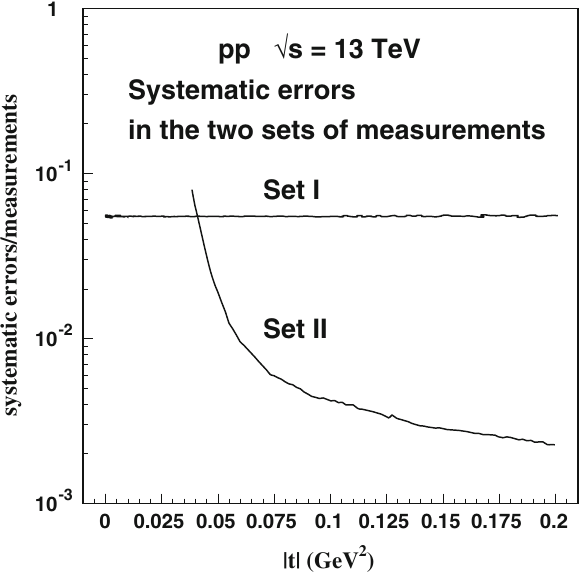
Fig. 2 Analytical representation of all data points of Totem measure- ments at 13 TeV [1,2], using 4 adjusted parameters [5–7,12] for each of the real and imaginary parts. The total of 428 data points is described with χ 2 = 1 . 567 (statistical and systematic errors added in quadrature) and χ 2 = 5 . 186 (statistical errors only). Details are given in Sects.